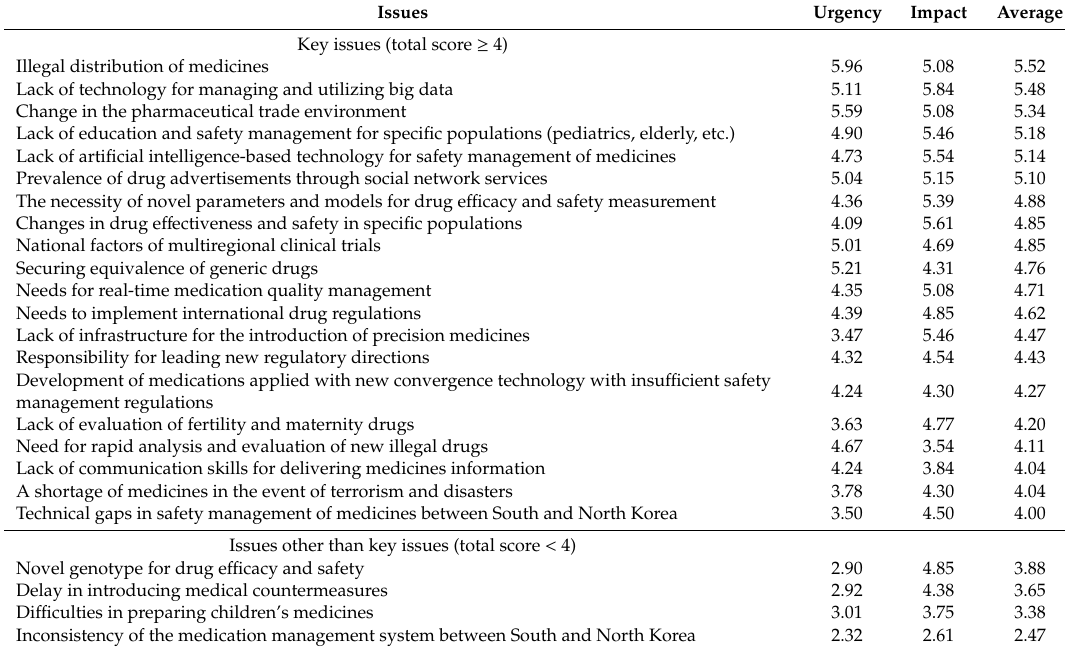
Table 2. Urgency and impact of issues in safety management of